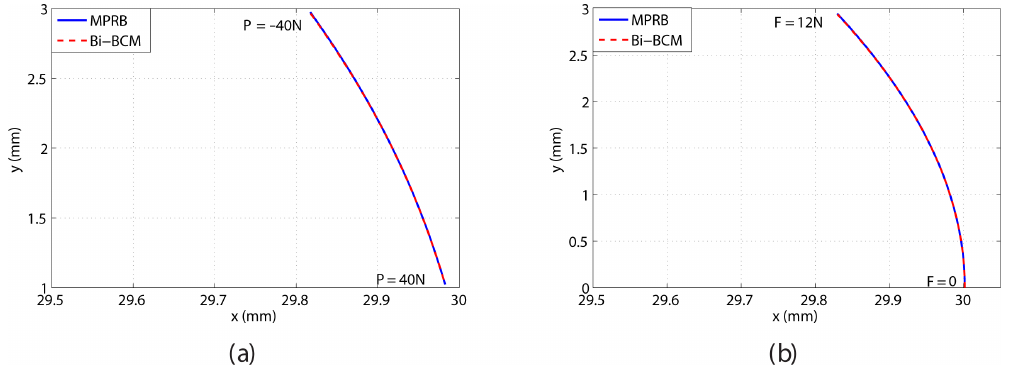
Figure 5. Comparisons between the proposed MPRB model and Bi-BCM model. (a) F = 5N with different axial forces. (b) P = 20N with different transverse forces.